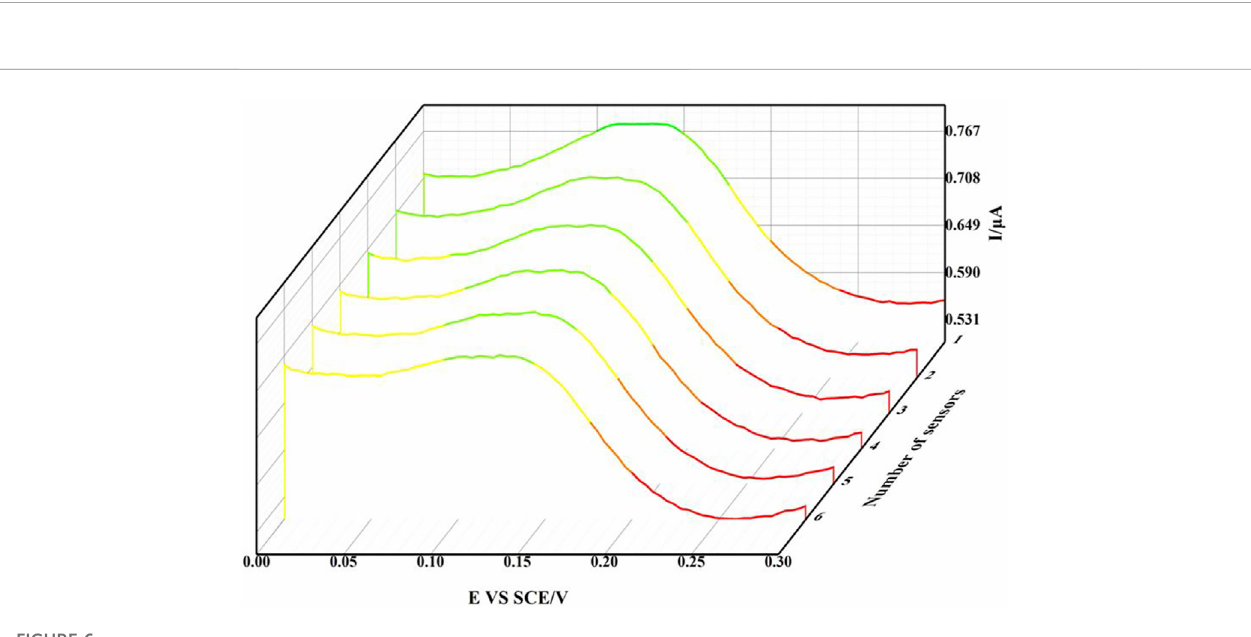
FIGURE 6 Three-dimensional waterfall diagram of DPV curve of six sensors.